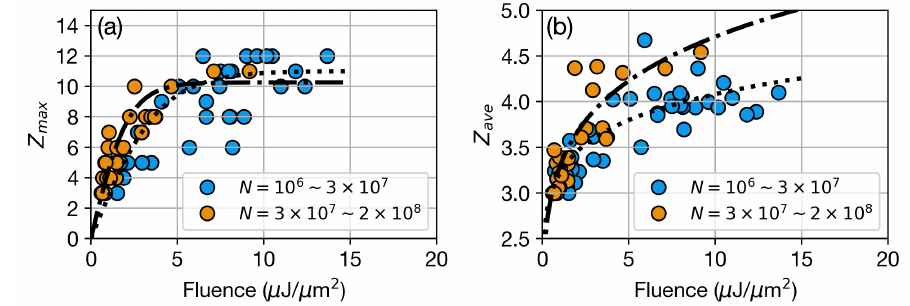
Figure 6. XFEL fluence dependence on the charge state of Xe ions. ( a ) The observed maximum charge state Z max . ( b ) The apparent averaged charge state Z ave calculated by weighted averaging over the peaks in the TOF spectrum corresponding to the charge state ≥ 3. The dashed lines and the dotted lines in ( a , b ) are the guides for the